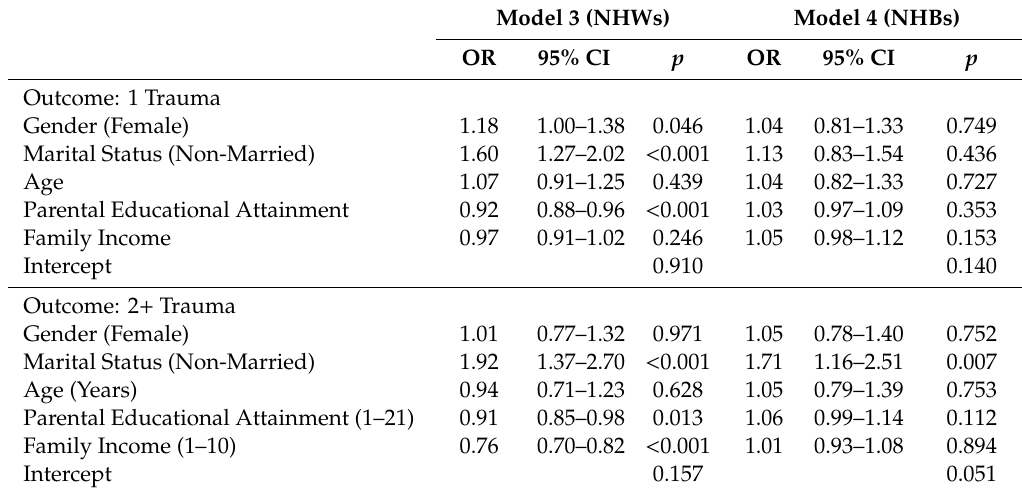
Table 3. Summary of polynomial regressions by race / ethnicity ( n = 4696)